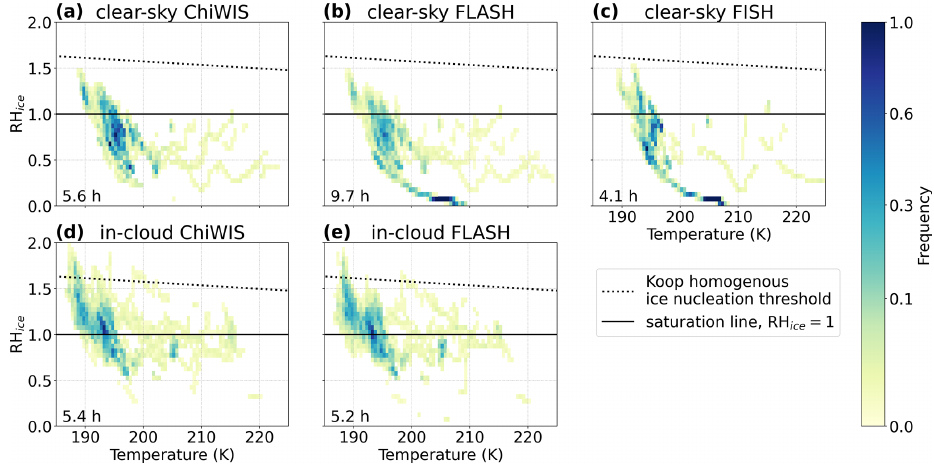
Figure 7. Relative humidity with respect to ice plotted against temperature for clear-sky regions for (a) ChiWIS, (b) FLASH, and (c) FISH and for cloudy regions for (d) ChiWIS and (e) FLASH. The number of measurements in each 0.05 (unitless) by 0.5K bin is shown as a normalized frequency (so area under the histogram integrates to 1); total hours of measurements labeled in bottom left corner (Table 2). The dotted line shows the homogeneous nucleation threshold calculated according to Koop et al. (2000). Because the ChiWIS dataset excludes cases when cell pressure is out of regulation, panel (a) does not include very low stratospheric RH ice ; see Fig. S8 for all